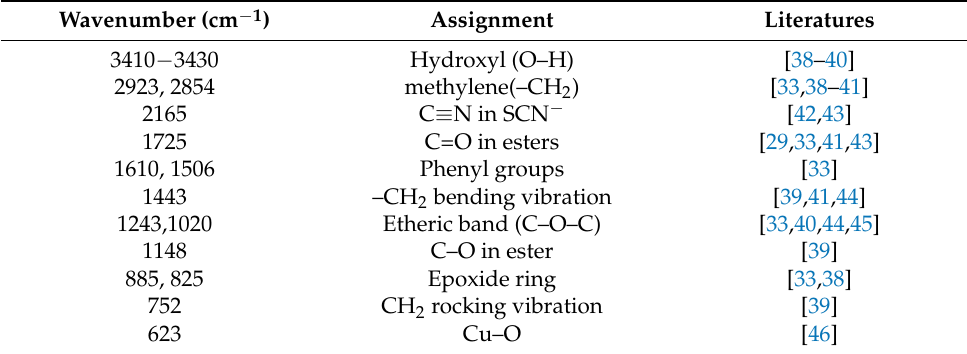
Figure 9. Infrared spectra of W2 coating system in 3.5% NaCl for different times. Table 2. IR band assignments for the primer, intermediate coat and topcoat.